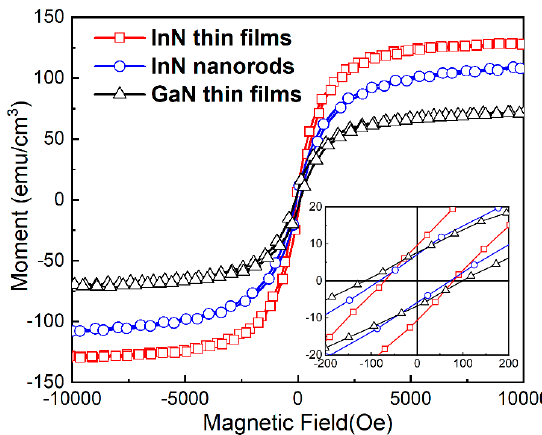
Figure 3. Magnetic properties of InN samples (Cr:2.5%) on GaN substrates at 300 K. Inset shows hysteresis at lower fields.